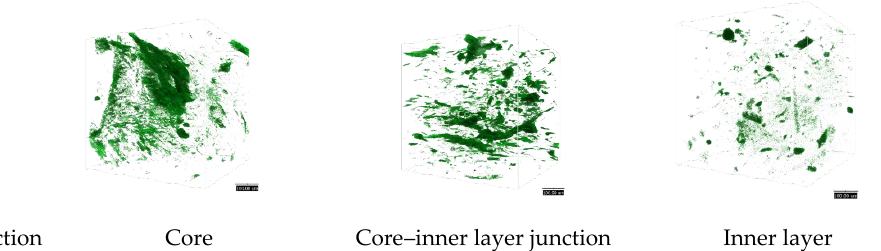
Figure 7. Tomographic images of MB051, MB055, MB056, and MB059 which provided visualization of internal structure (brown), and pore and crack (green). The length of scale bars located at the bottom right corner or top right corner of images is 100.00 µm. Table 5. Comparison between average elemental compositions of Ban Muang Bua pottery in previous (Data from [20]) and present works. Adapted with permission from Nimsuwan, N.;